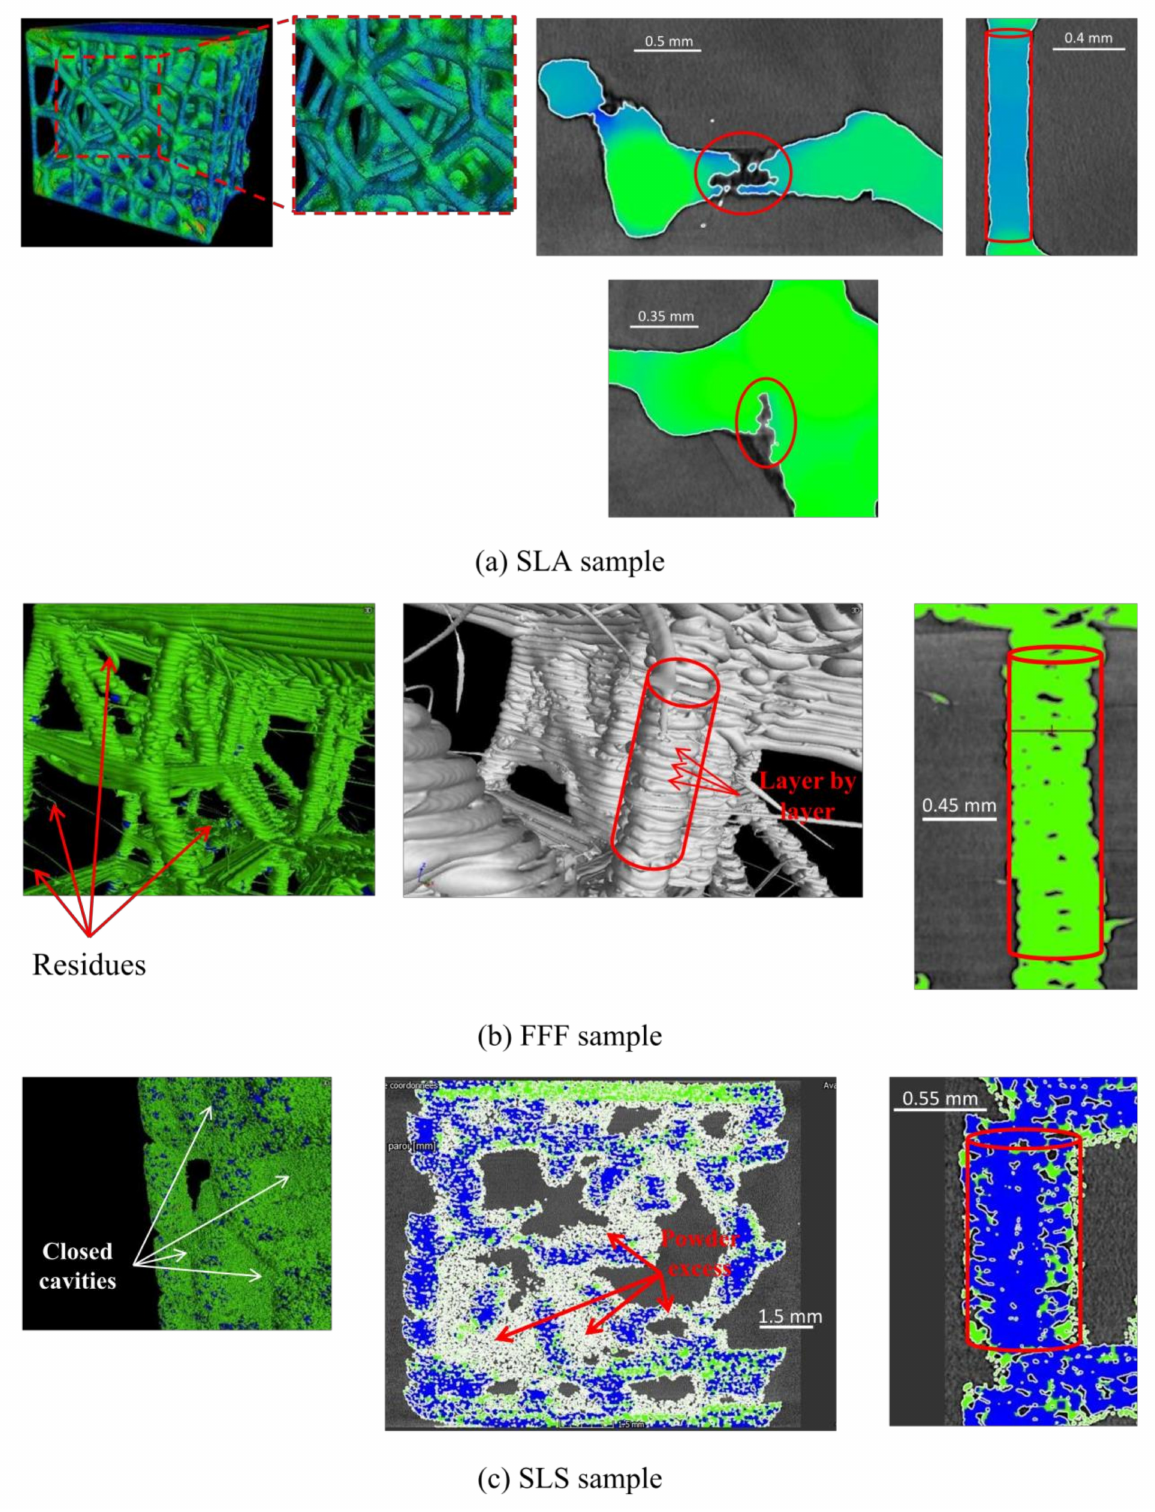
Figure 5. Tomography observations of the quality of samples from 05 to 10. For the samples obtained by FFF, a lower quality is observed compared to that obtained by the SLA process, even if it remains acceptable (Figure 5b). Even though the process parameters have been optimized, printing residues remain and were observed on all the samples, as highlighted by previous studies [24]. These residues are mainly due to